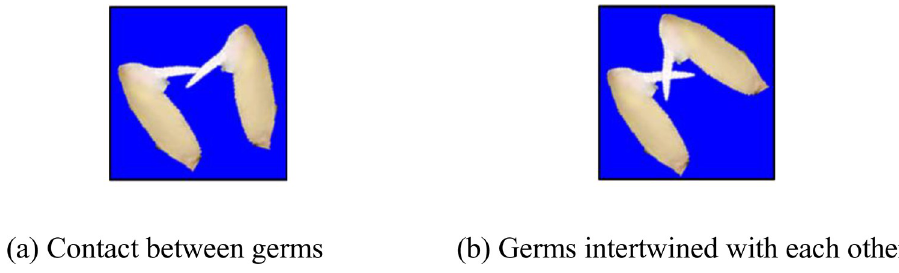
Fig 14. The germs are intertwined or in contact with one another.